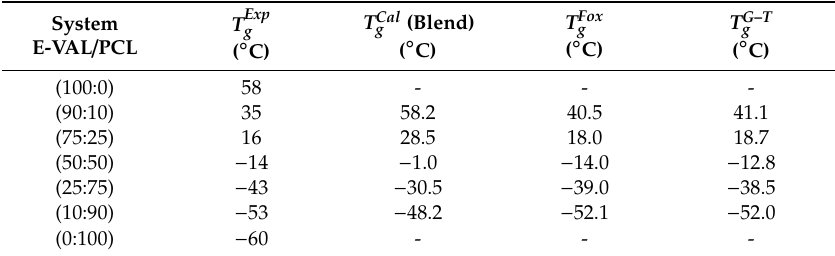
Figure 5. Heating differential scanning calorimetry thermograms of E-VAL/PCL blends and their pure components. Table 2. Comparison of the glass transition temperatures of the E-VAL/PCL blend with different compositions determined by experiment, calculation, and using the Fox equation and Gordon–Taylor equation.